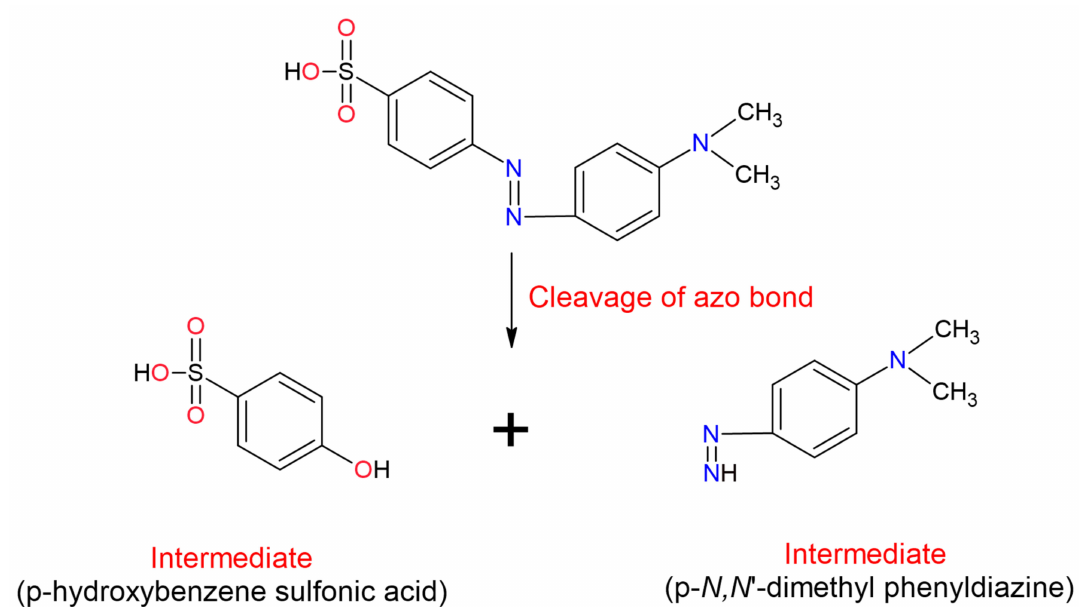
Figure 4. Route of degradation of azo dye Methyl Orange by laccase proposed by Telke et al., (2010). The excision of the dye is observed, and the immediate intermediate dyes are obtained